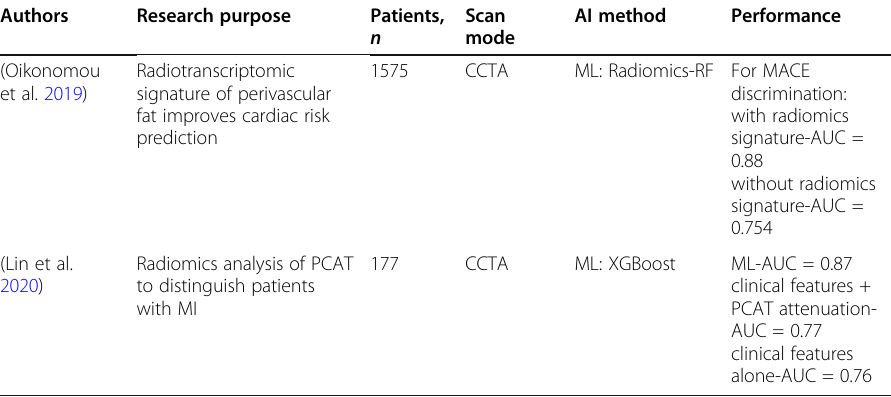
Table 1 Characteristics of studies included in the systematic review (Continued)